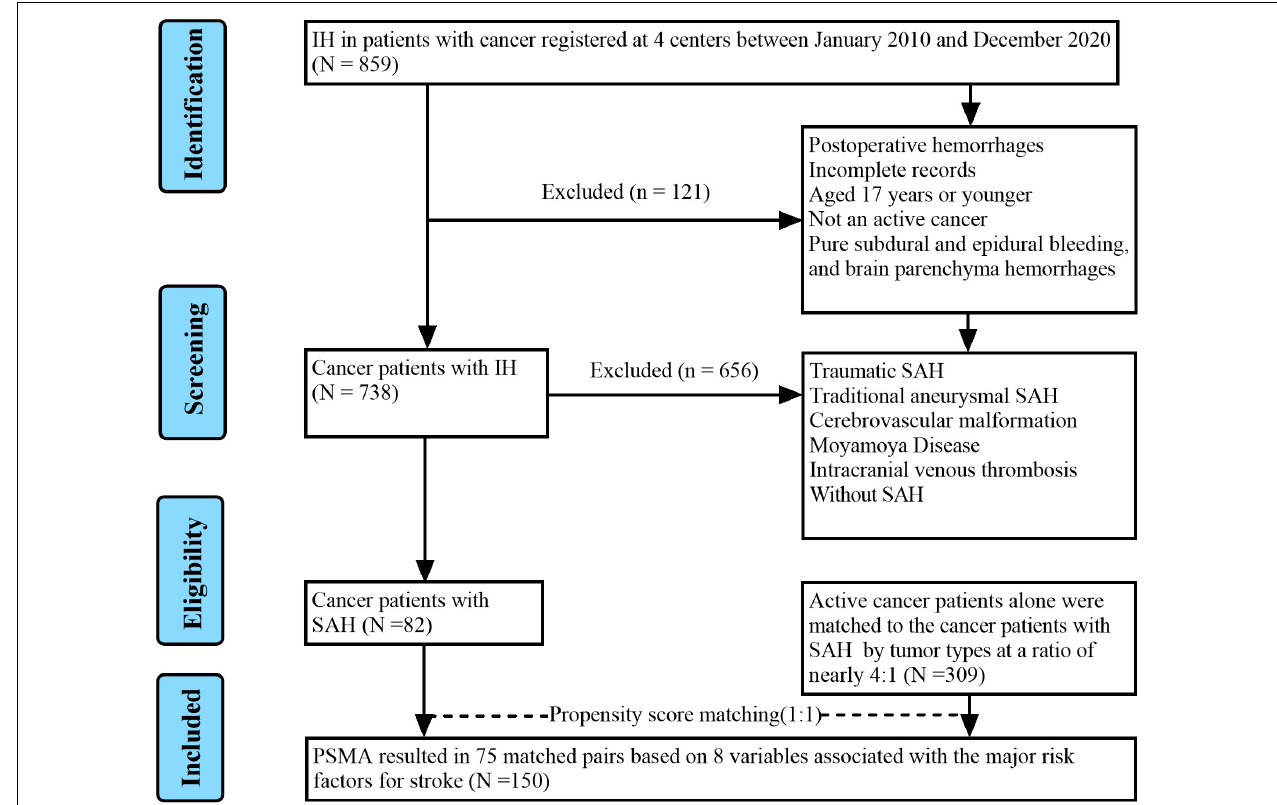
FIGURE 1 | Flowchart of patient